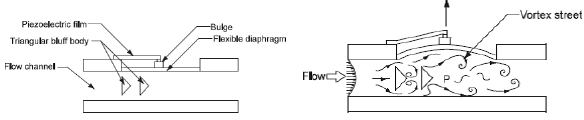
Figure 1: Miniature energy harvesting device using two triangles in tandem (from